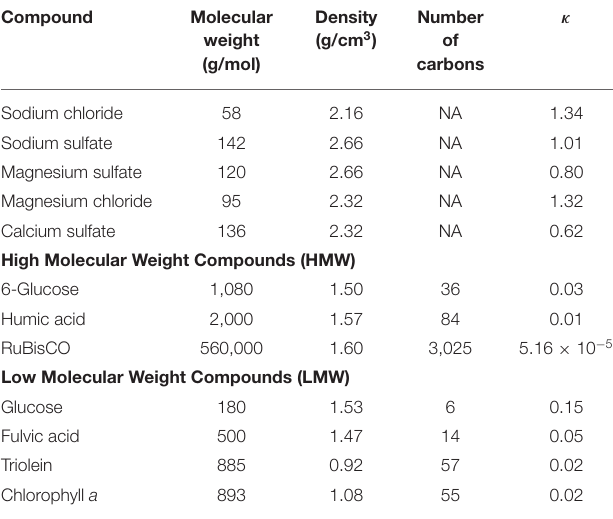
TABLE 3 | Properties of inorganic and organic